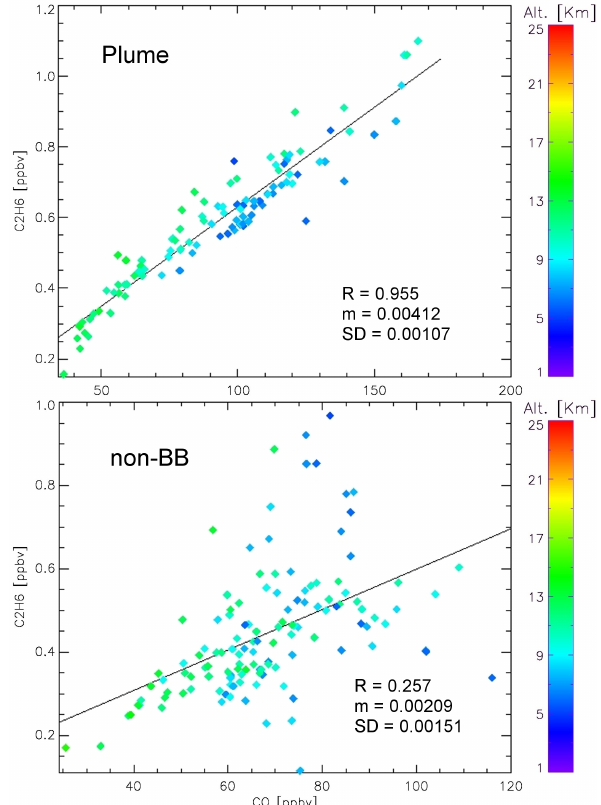
Fig. 3. C 2 H 6 -CO correlations for ACE-FTS measurements made in July 2008. (Upper panel) Correlations from approximately 30 occultations ( n = 120) containing measurements of Boreal biomass burning plumes in Canada (2–3 days old). The high positive ( R ) co- efficient for C 2 H 6 indicates its presence in the plume as a primary pyrogenic species. (Lower panel) Correlations of an equivalent number of off-plume, non-biomass burning measurements made during the same time period at similar